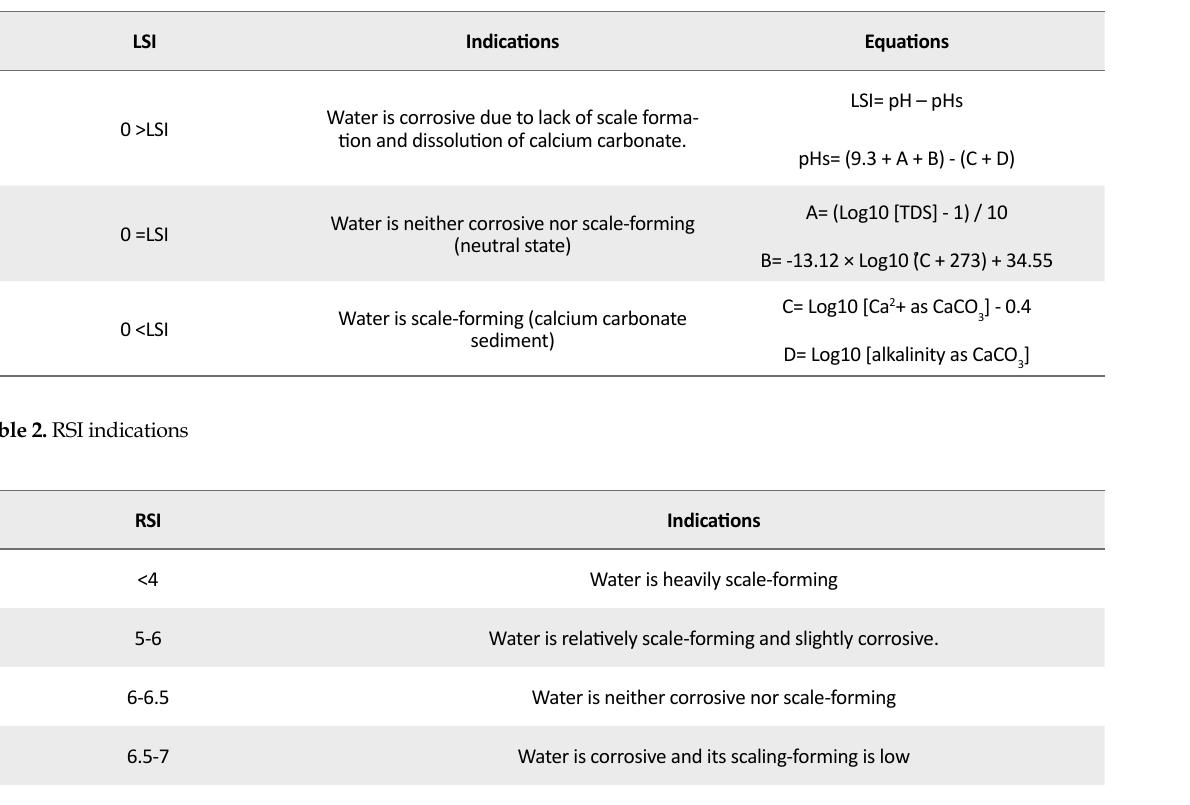
Table 1. LSI indications and equations